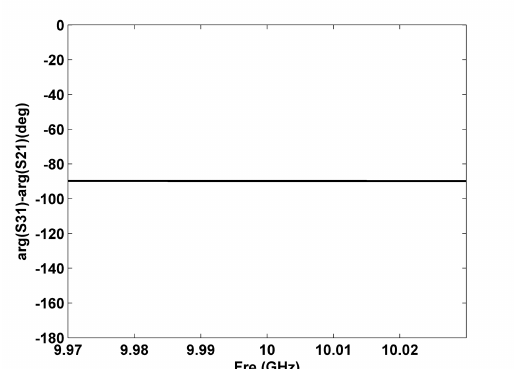
Figure 3. Phase characteristic of the designed directional coupler.